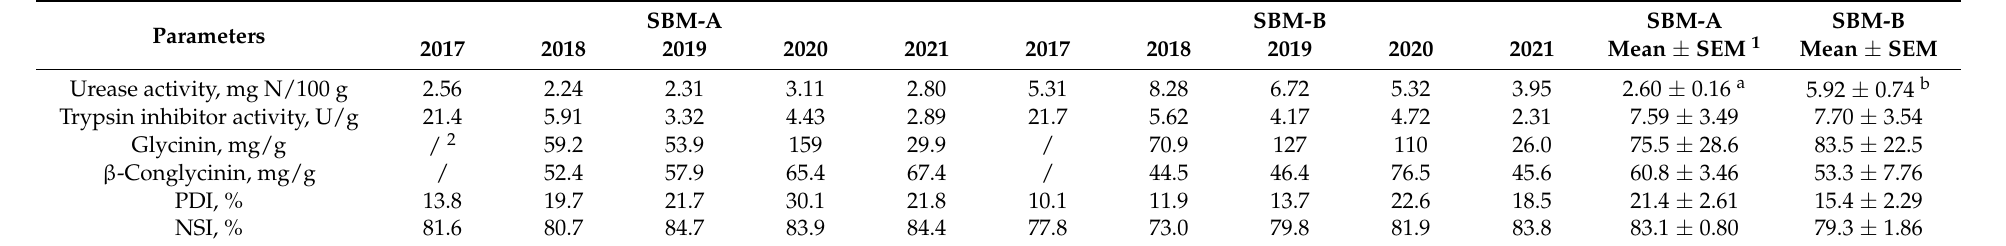
Table 4. Anti-nutritional factors and physicochemical properties of tested soybean meals (SBMs) processed on the same production line with beans from different origins.